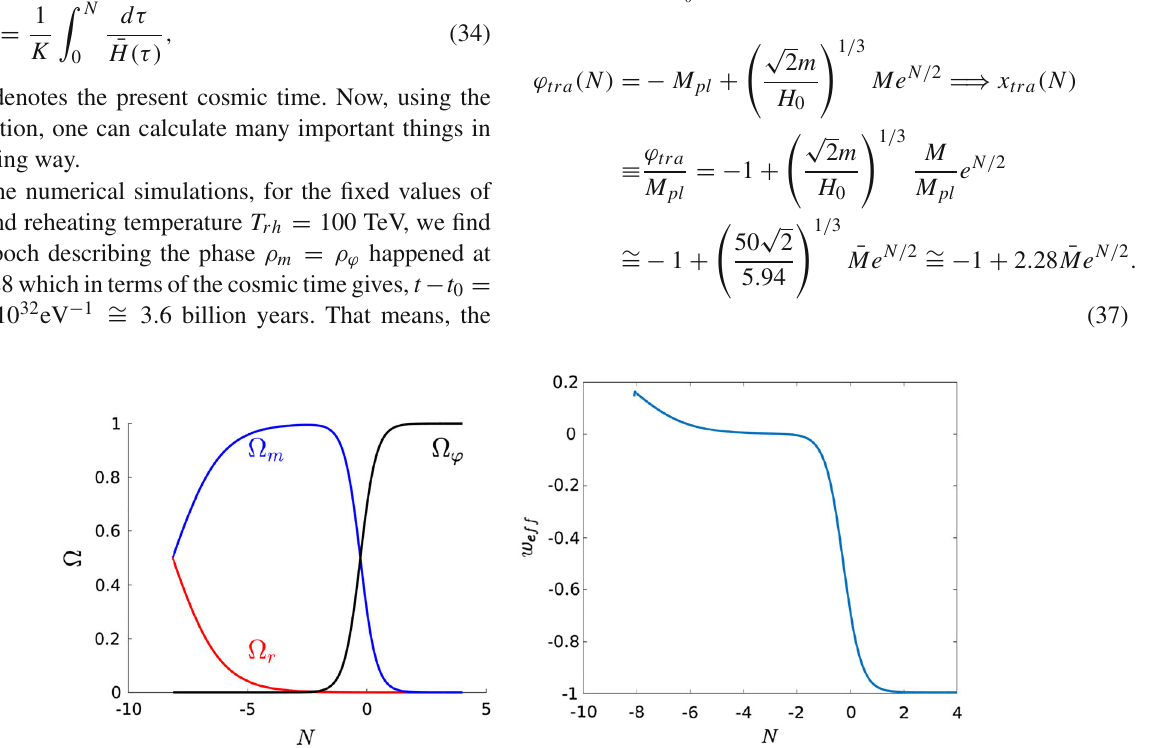
(cid:14) 0 . 3, (cid:13) (cid:14) 0 . 0 and w (cid:14) − 0 . 8, while at late time, the respec- (cid:13) m r ef f tive quantities tend to 1 , 0 , 0 and − 1. Moreover, from the graph of w ef f (right panel) one can see that after the matter-radiation equality the uni- verse enters into the matter dominated era (i.e., w ef f = 0) and then subsequently enters into the present accelerated regime and asymptoti- cally approaches toward w ef f = −